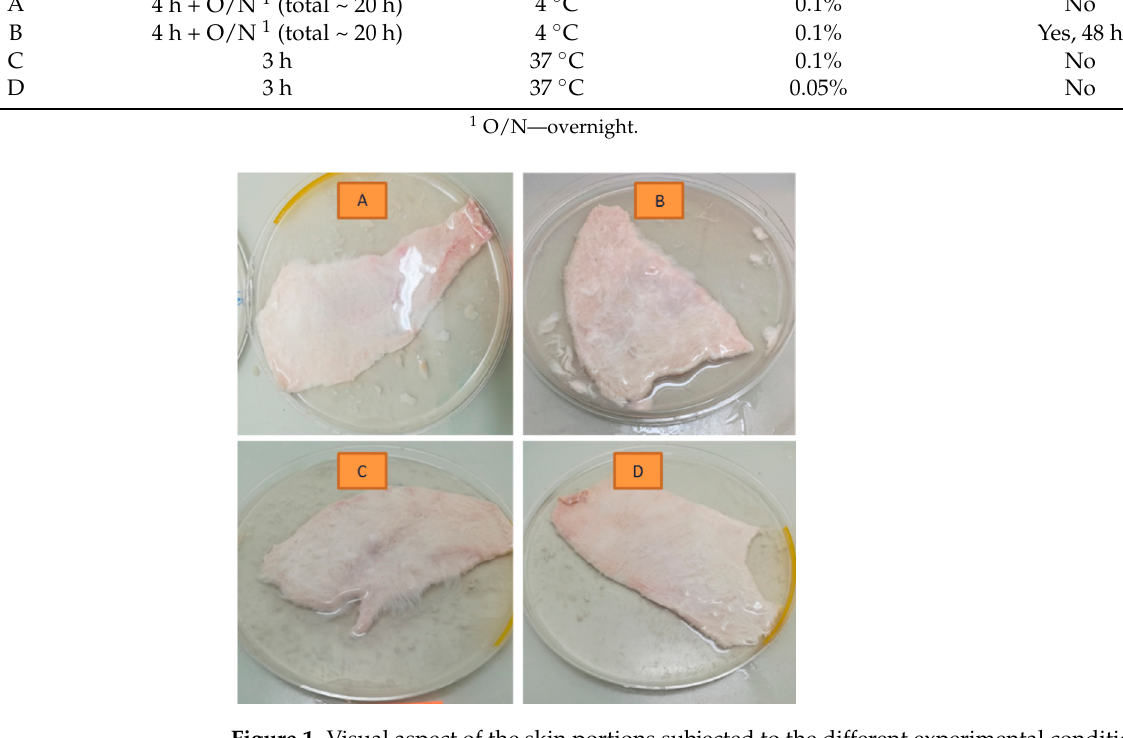
Table 1. Experimental conditions considered for the trypsin digestion of the pig ear skin to obtain SC layer. Condition